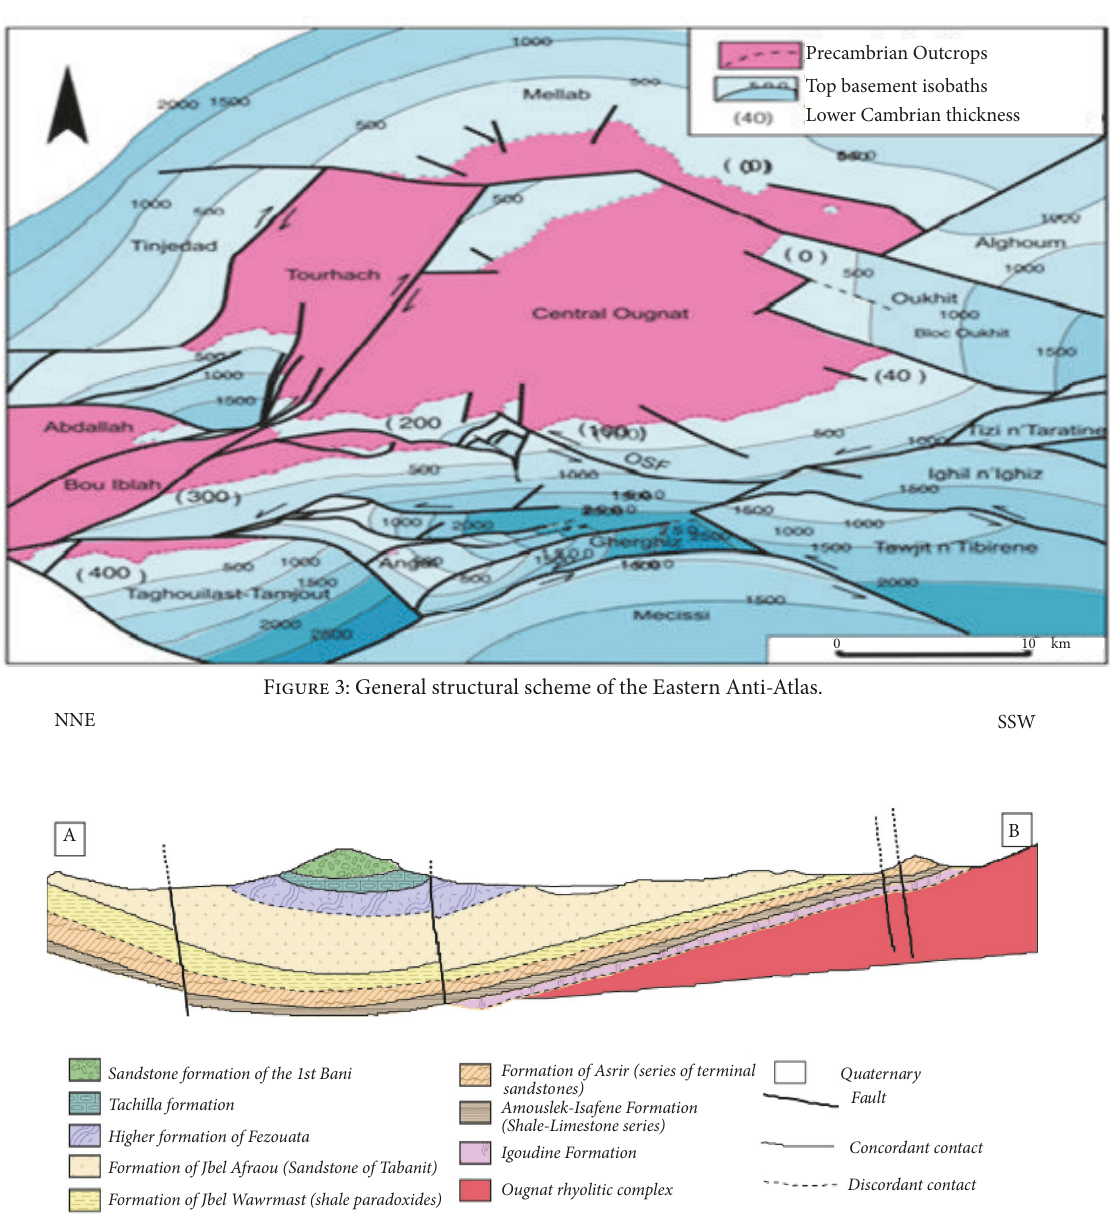
Figure 4: Synthetic geological section made in the area of Taroucht.